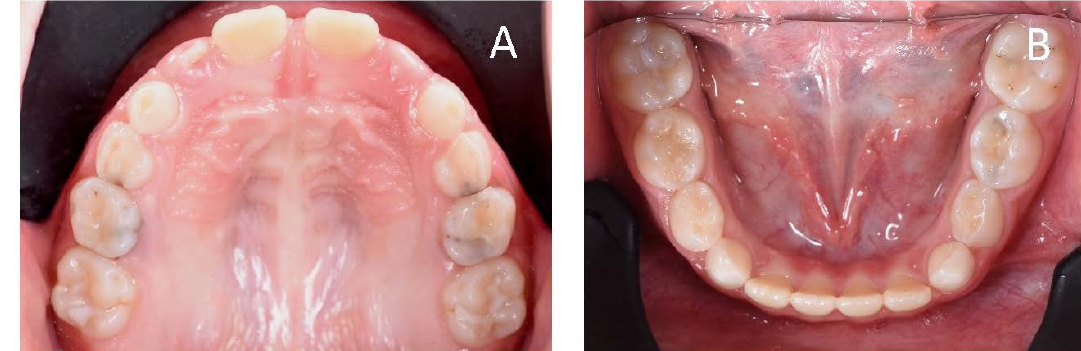
Figure 17. Intraoral photographs at the end of the treatment (8-year-old). ( A ) Frontal view; ( B , C ) lateral view.